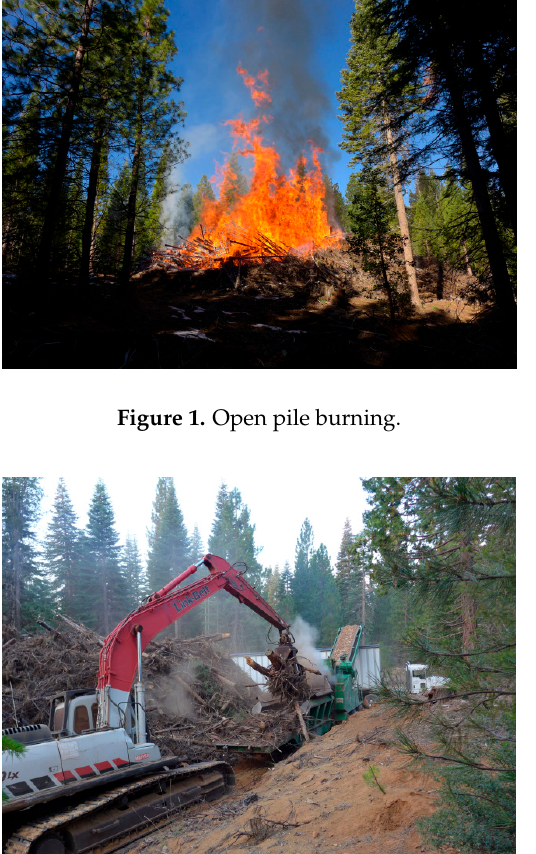
Figure 2. Grinding operation.